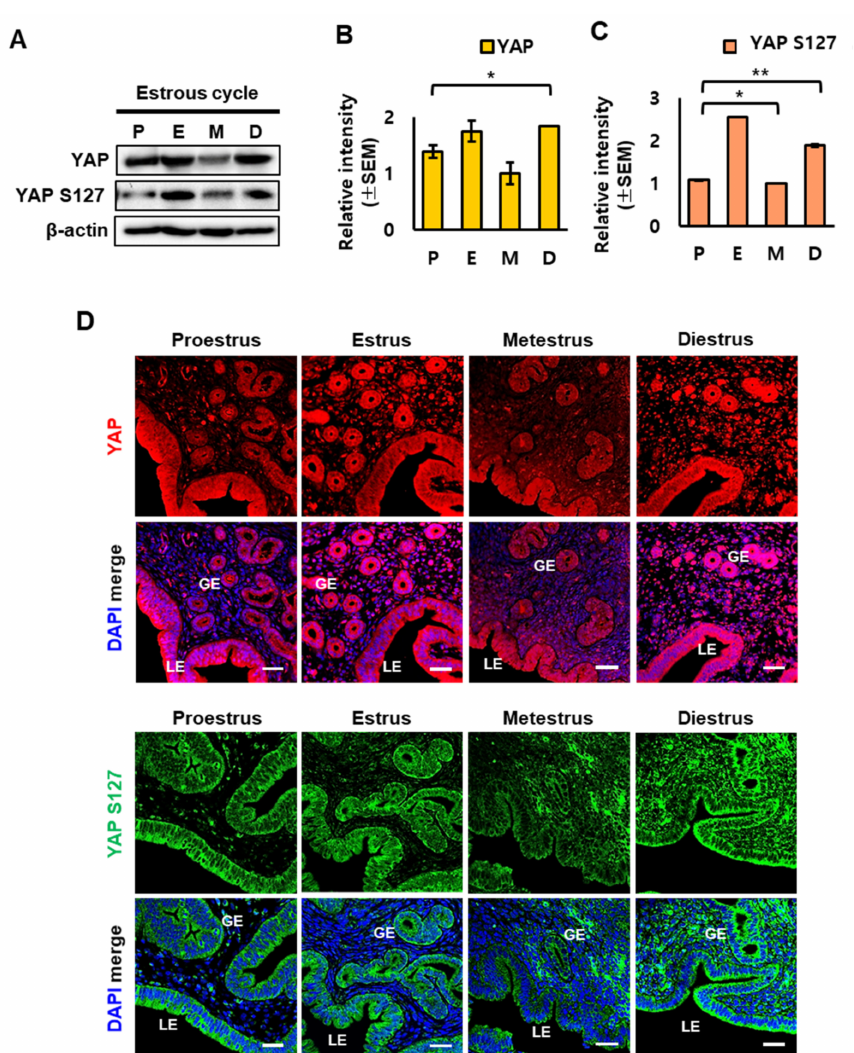
Figure 2. Localization of YAP and phospho-YAP in the mouse uterus during the estrous cycle. ( A ) Western blot analysis of YAP and phospho-YAP (YAP S127) proteins was performed using whole tissue lysates from the mouse uterus during the estrous cycle. ( B , C ) Quantification of relative